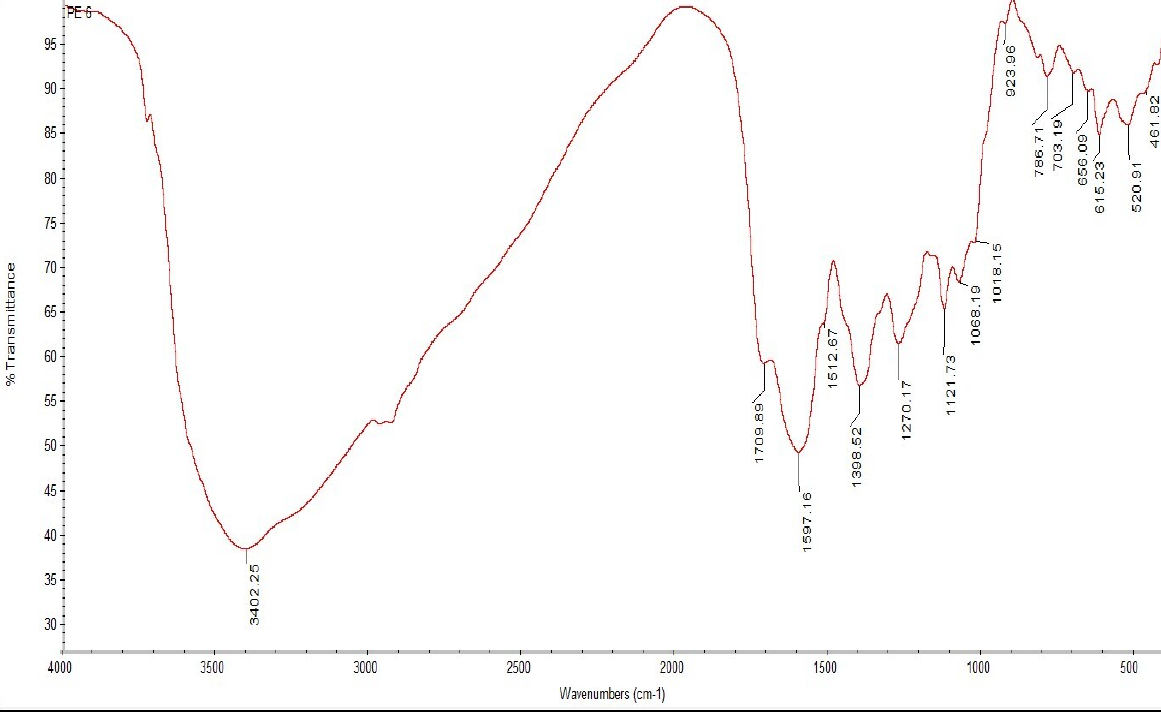
Figure 5. FTIR spectra showing the peaks of aqueous leaf extracts of V. leucoxylon.